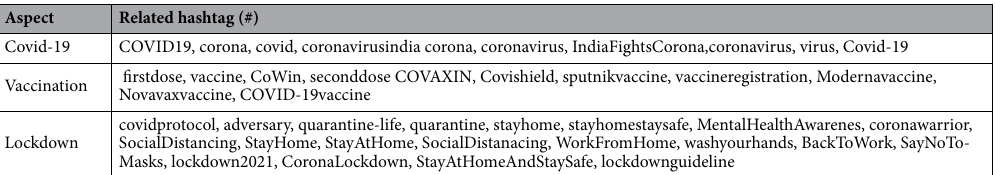
Table 3. Top frequent tag used in collecting data from twitter.